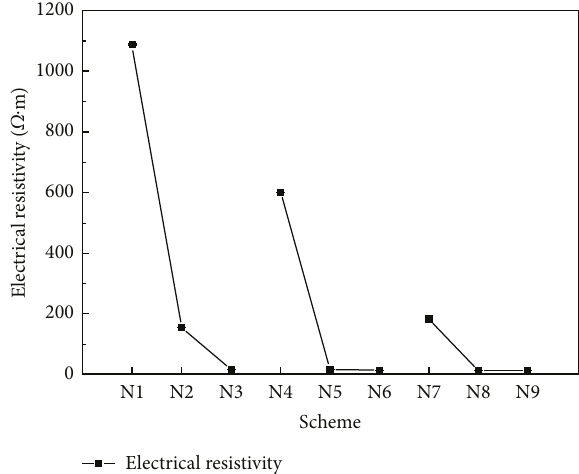
Figure 8: Resistance test results of rutting plate